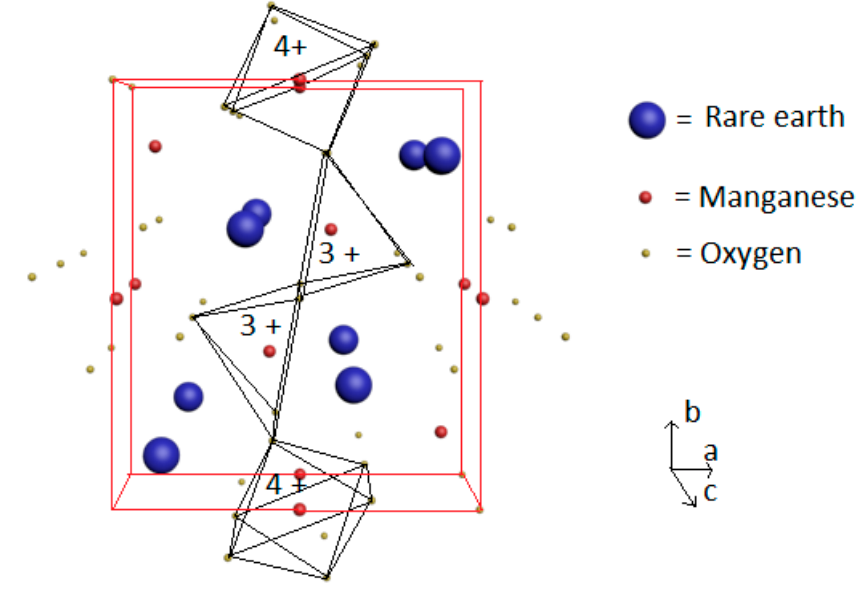
Figure 12. RMn 2 O 5 orthorhombic structure. Each Mn 3+ (red) is encased in the oxygens’s (grey) pyramid while Mn 4+ ions (red) are encased in the oxygens’s octaedra.